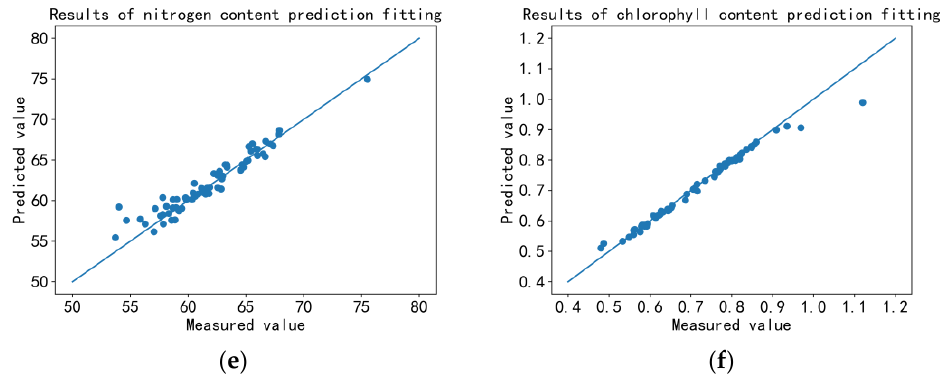
Figure 9. The predicted value–measured value fitting curve: ( a ) moisture content; ( b ) free amino acid content; ( c ) tea polyphenol content; ( d ) sugar content; ( e ) nitrogen content; ( f ) chlorophyll content. Table 6. Accuracy evaluation table of prediction